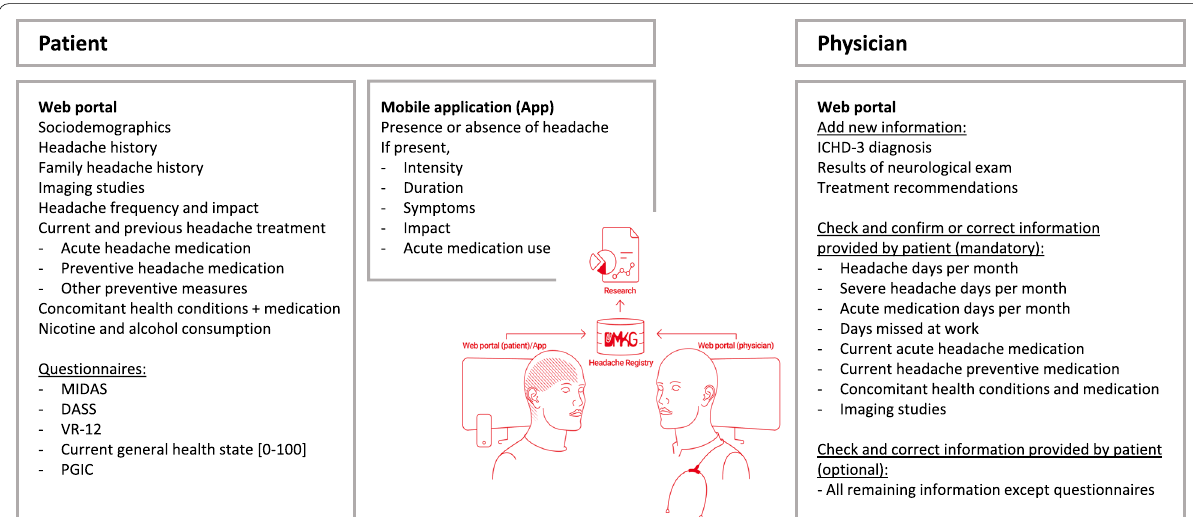
Fig. 1 Overview of data capture within the DMKG Headache Registry. Data are entered by the patient before the first appointment and updated before every follow-up appointment. During or after the visit, the physician adds, corrects or confirms some central data and closes the visit. Assessment of headache treatment from the patient includes reasons for discontinuation for stopped treatments and rating of efficacy, tolerability, satisfaction with treatment and indication of side effects according to the GASE scale. PGIC is assessed only starting from the second visit. MIDAS, migraine disability assessment score; DASS, depression anxiety stress scales; VR-12, veterans RAND 12-item health survey; PGIC, patient global impression of